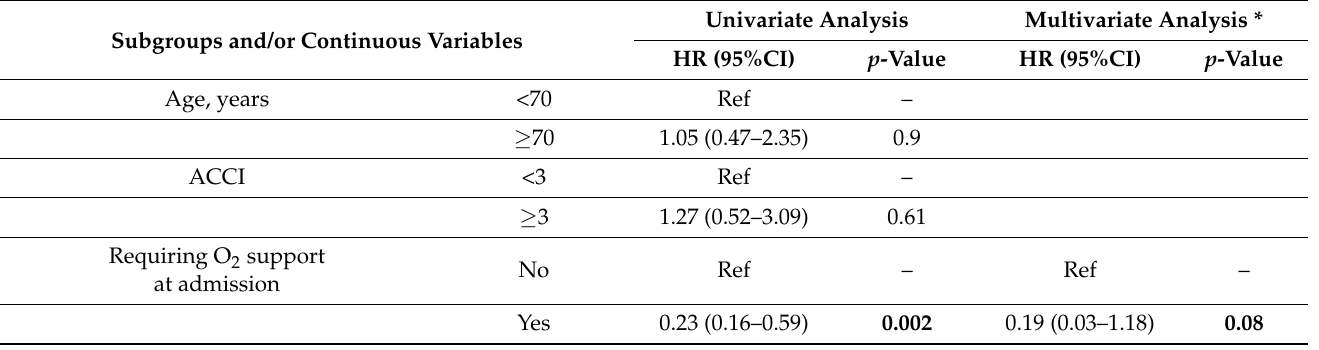
Table 2. Cox Proportional Hazards Model assessing variables influencing time till negative